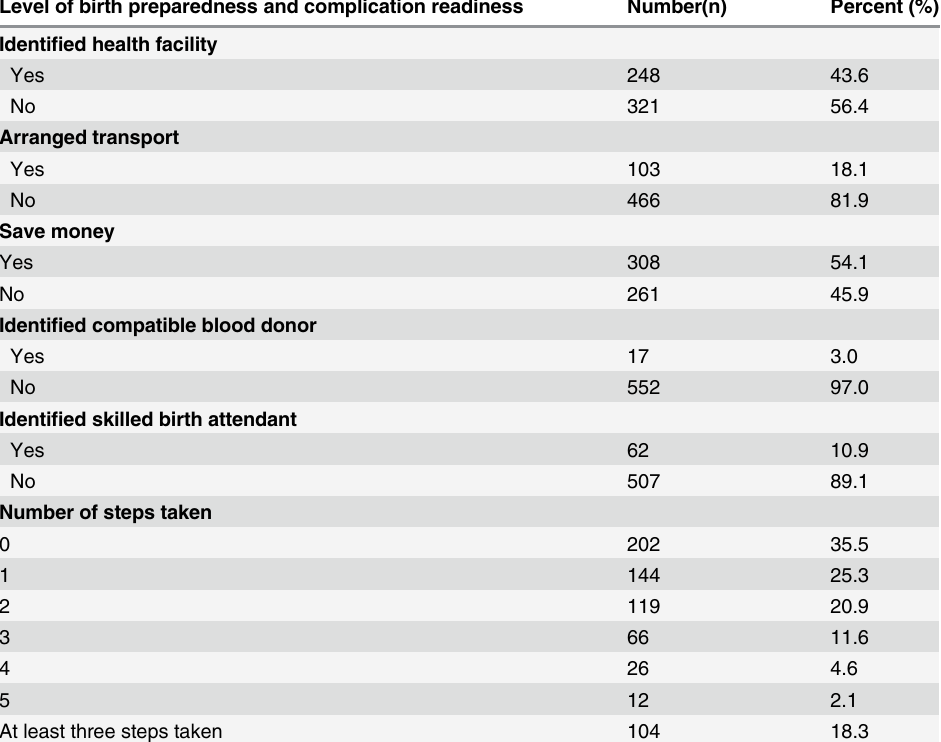
Table 3. Birth preparedness and complication readiness among pregnant women in Duguna Fango District, 2013 (n = 569). This table shows Birth preparedness and complication readiness among pregnant